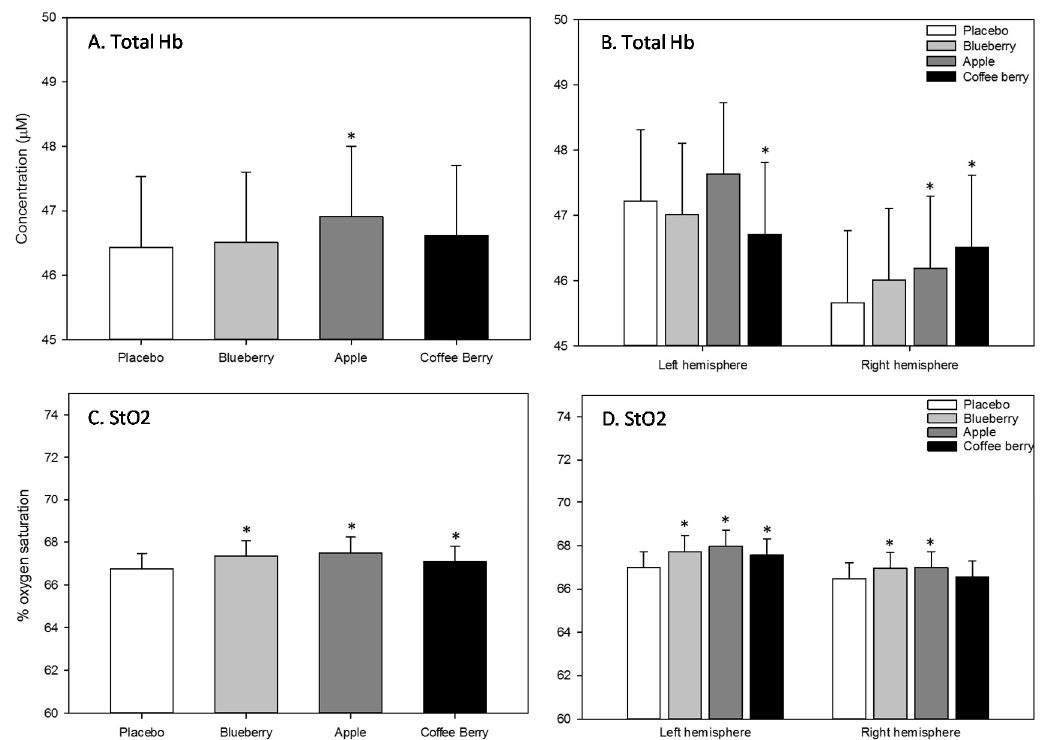
Figure 4. Near-infrared spectroscopy (NIRS) outcomes. Significant main effects of treatment ( A . Total Hb and C . StO2) and significant treatment x hemisphere interactions ( B . Total Hb and D . StO2) were observed for all outcomes ( n = 32). Values are adjusted means ± SEM derived from the linear mixed model. Treatment, hemisphere (left/right) and epoch (11 × 4/5 min epochs during each assessment = 33 epochs) and their interactions, i.e., treatment × hemisphere × epoch; treatment × hemisphere; treatment × epoch, hemisphere × epoch were entered into the models as fixed effects. Respective pre-dose values (baseline assessment) were also entered into the model as a covariate and subject was included as a random effect. Post-hoc comparisons were made between placebo and each of the active treatments using a Bonferroni adjustment for multiple comparisons. *, p < 0.05 (post-hoc test against placebo); Total-Hb, total hemoglobin; StO 2 , oxygen saturation.